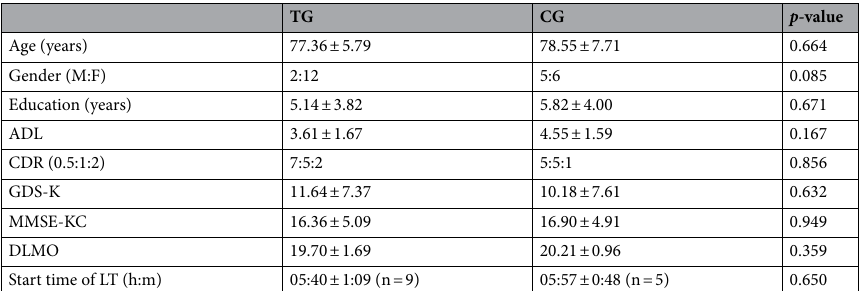
Table 1. Baseline characteristics in the TG (N = 14) and CG (N = 11). Independent-t test or X 2 test, Data are shown as Mean ± SD or Ratio. TG treatment group, CG control group, ADL activities of daily living, CDR Clinical Dementia Rating, GDS-K Korean version of the Geriatric Depression Scale, MMSE-KC MMSE in the Korean version of CERAD Packet, DLMO Dim light melatonin onset, LT light